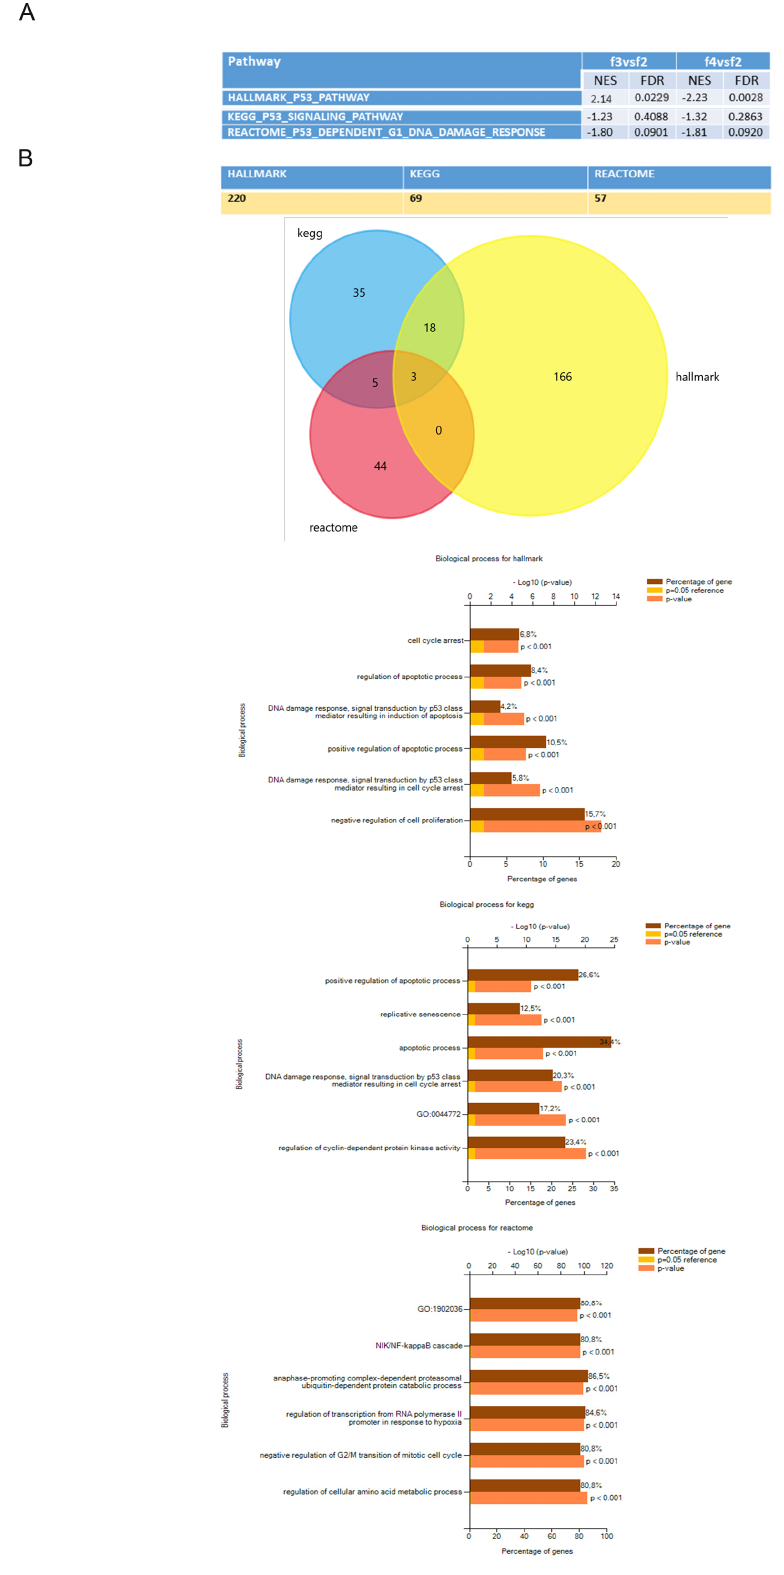
Figure 4. Evaluation of p53 pathway expression in different datasets. ( A ) Differential expression of p53 pathway in F3/F4 fractions versus F2 according to Hallmark, Kegg and Reactome. The table reports the Normalized Enrichment score (NES) and the False discovery rate value (FDR). ( B ) In the table above the number of genes of each dataset is reported. The bar graphs show at which